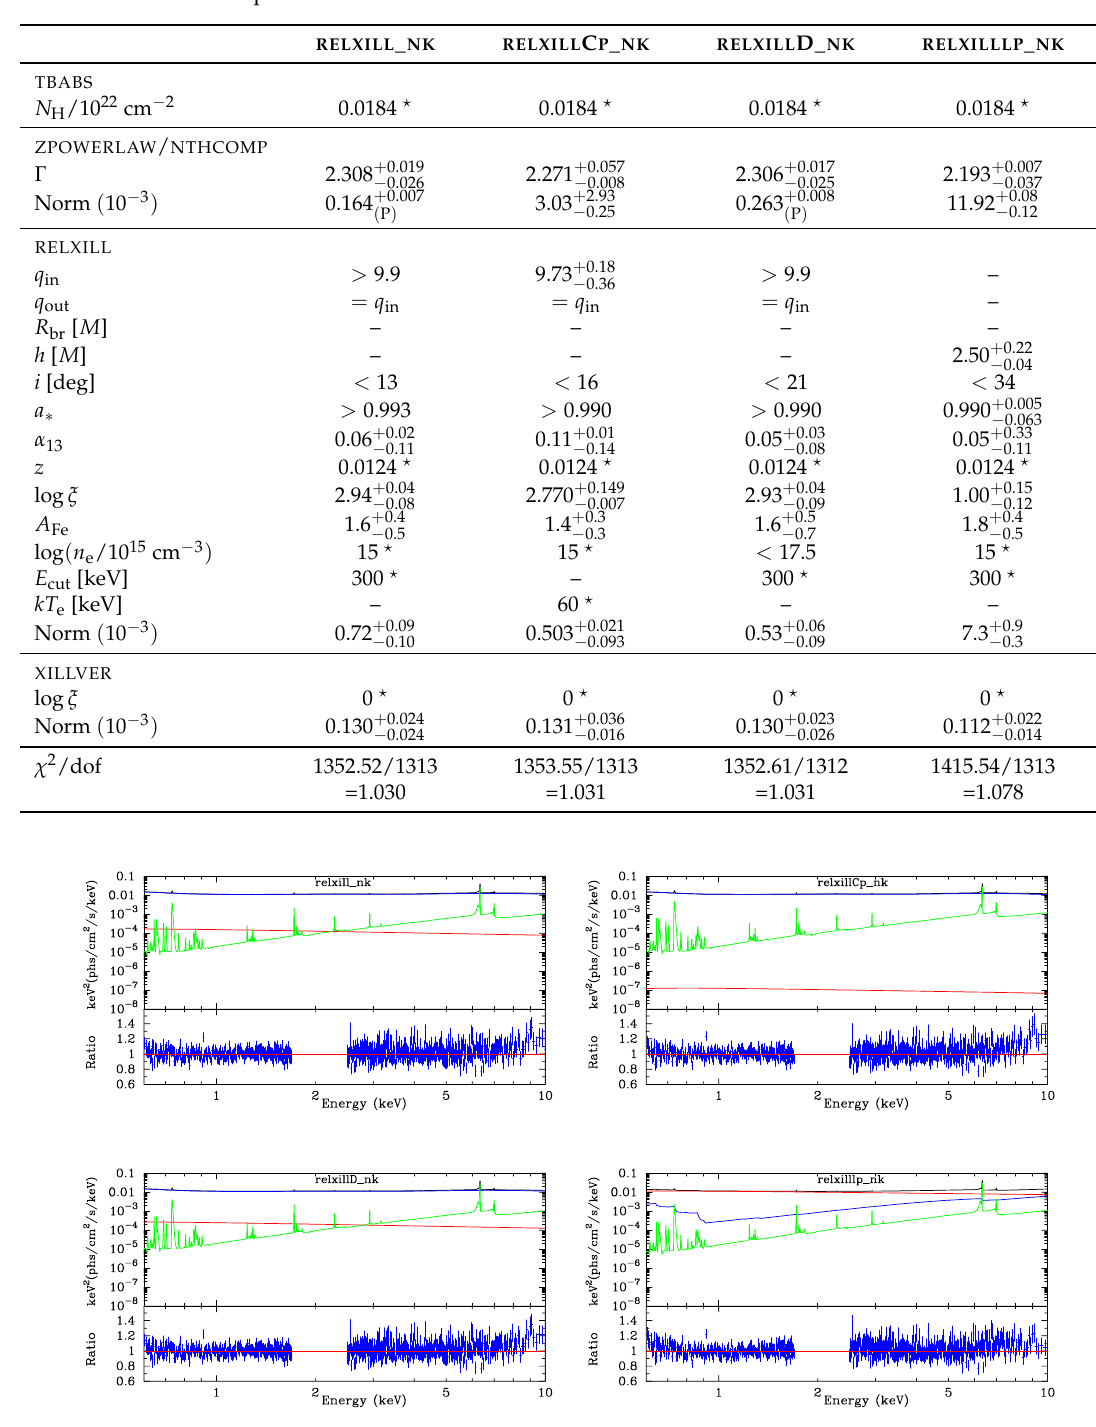
Figure A7. Spectra of the best fit models with the corresponding components ( upper panels ) and data to best-fit model ratios ( lower panels ) for Swift J0501–3239 when the reflection component is modeled by RELXILL _ NK ( top left panel ), RELXILL C P _ NK ( top right panel ), RELXILL D_ NK ( bottom left panel ), and RELXILLLP _ NK ( bottom right panel ). The total spectra are in black, power law components from the coronas are in red, the relativistic reflection components from the disk are in blue, and the non-relativistic reflection components from cold material are in